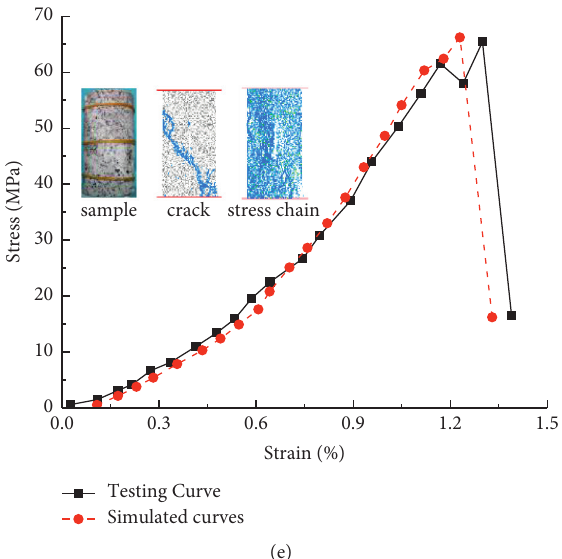
Figure 4: Failure characteristics of joint samples under uniaxial compression: (a) α � 0 ° , (b) α � 30 ° , (c) α � 45 ° , (d) α � 60 ° , and (e) α � 90 ° .